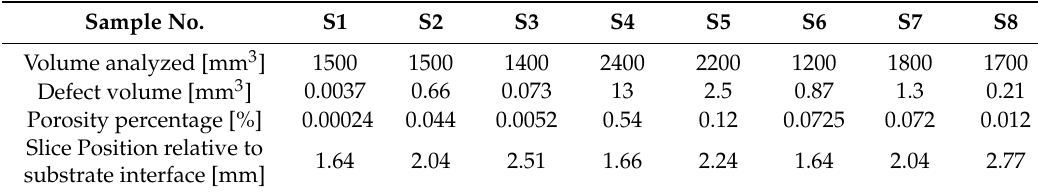
Table 5. Determined porosity for samples produced by